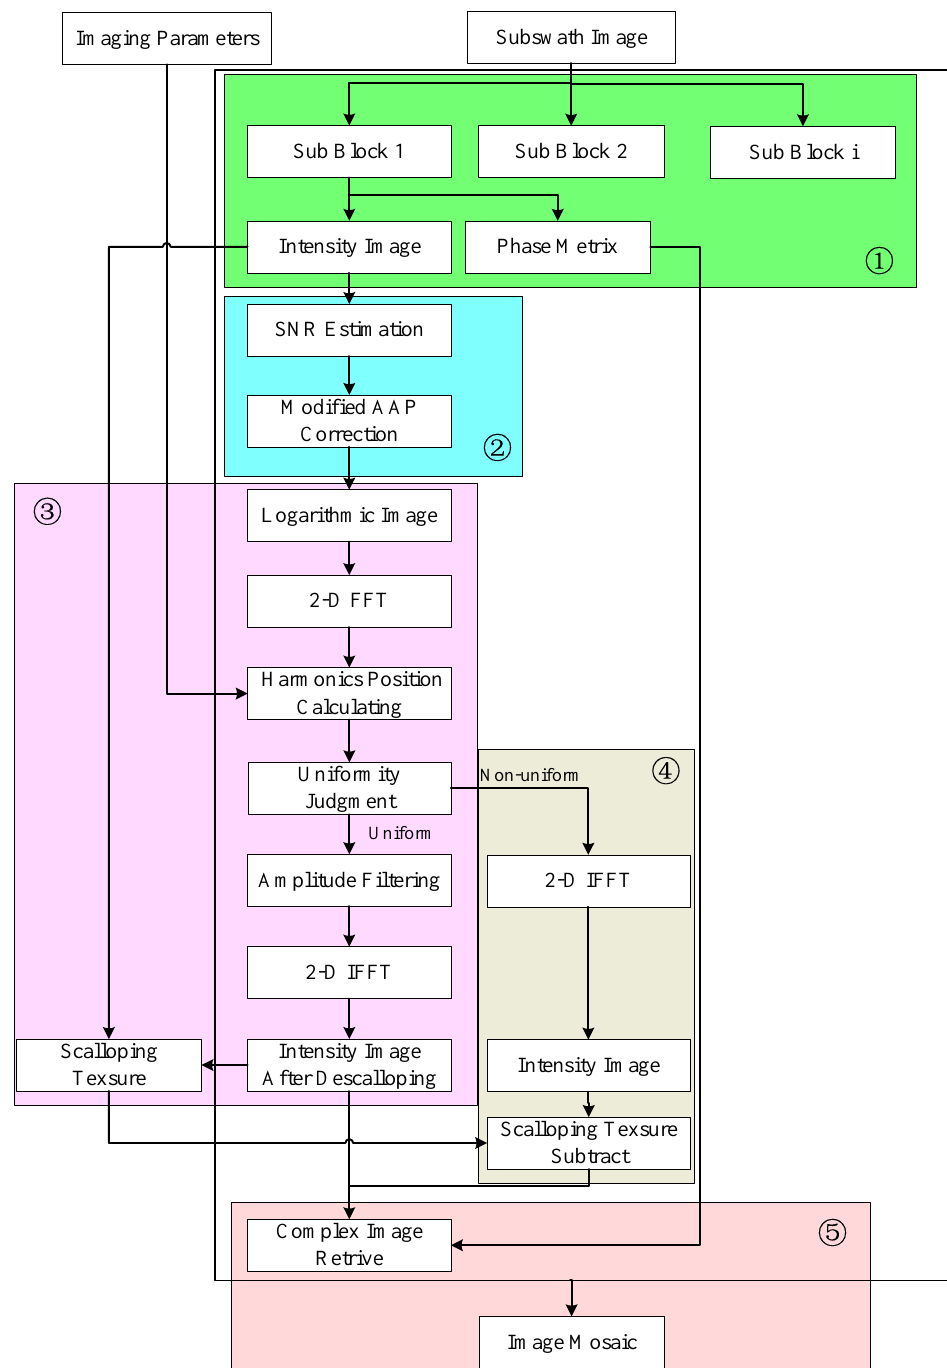
Figure 10. Flow chart of the improved descalloping method combined with imaging parameters.